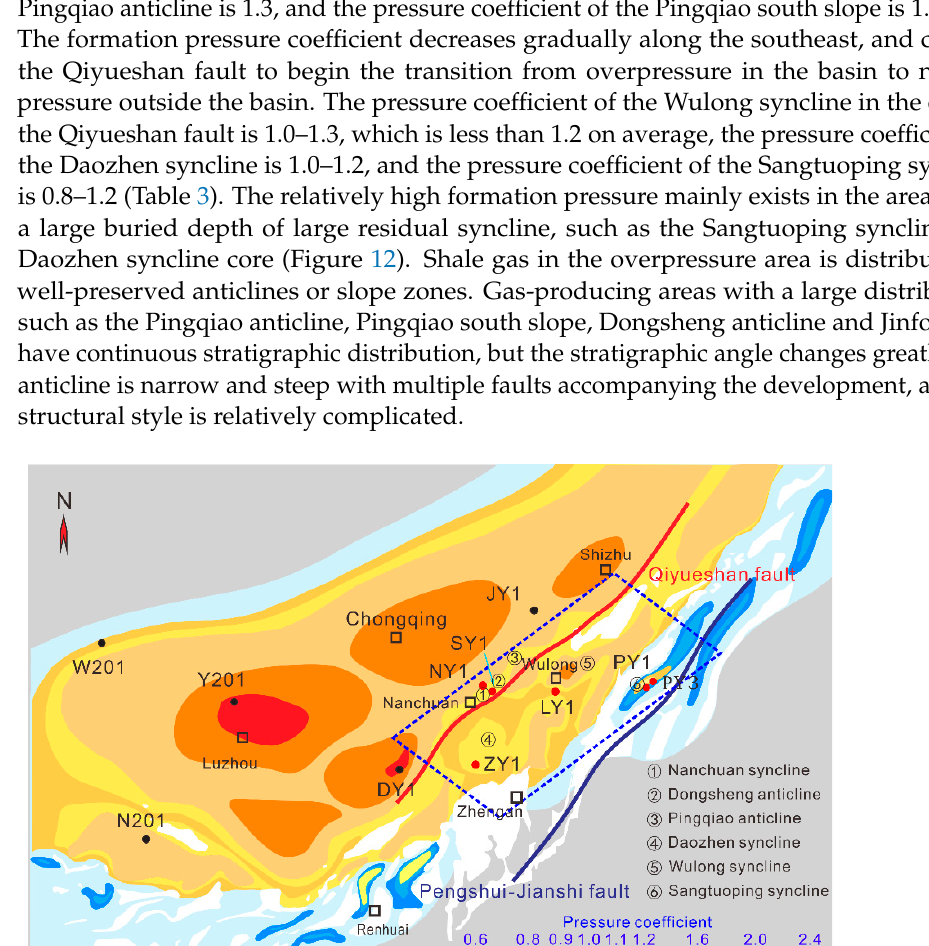
Figure 12. Coefficient of formation pressure in and around the Sichuan Basin (revised from reference [14]).